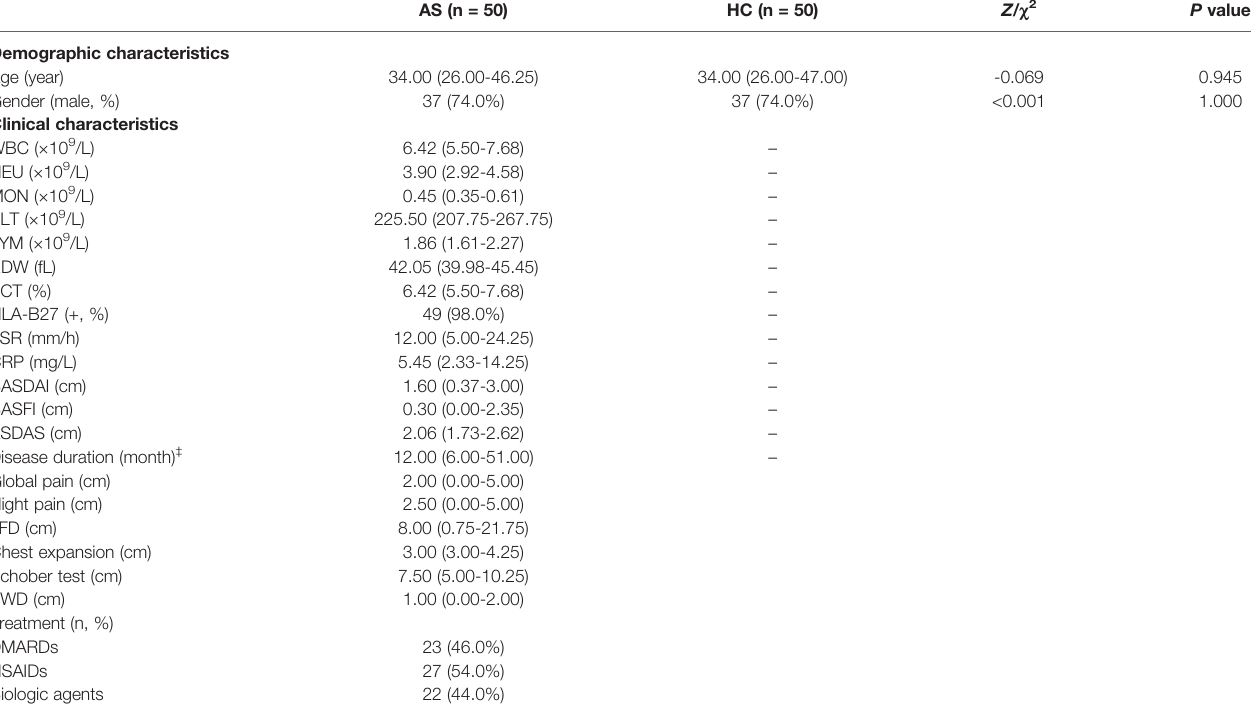
TABLE 1 | Demographic and clinical characteristics of